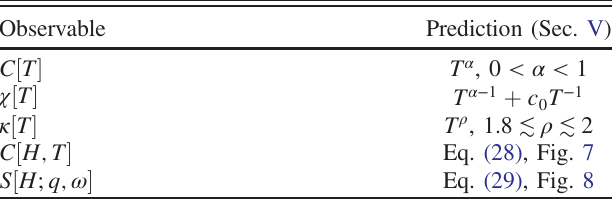
TABLE II. Shorthand summary of theoretical results for a few experimental observables within the framework of a d > 1 lattice-emergent random-singlet regime following the ideas dis- cussed above for a random frustrated Heisenberg model Eq. (1). These predictions, namely heat capacity, spin susceptibility, thermal conductivity, scaling of heat capacity in magnetic field, and in-field dynamical structure factor, are expected to be seen in YbMgGaO 4 and related systems at low temperatures.